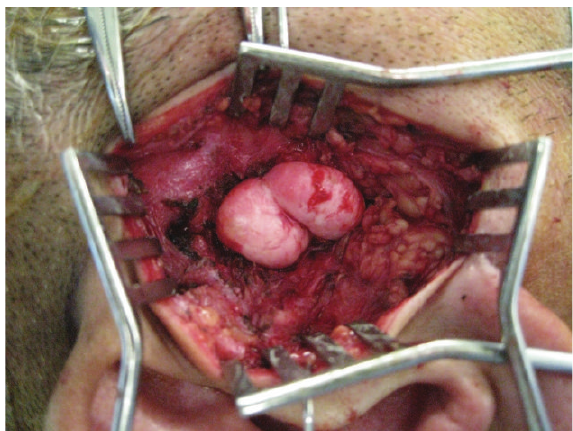
Figure 2: Intraoperative image shows en bloc excision of the tumor.